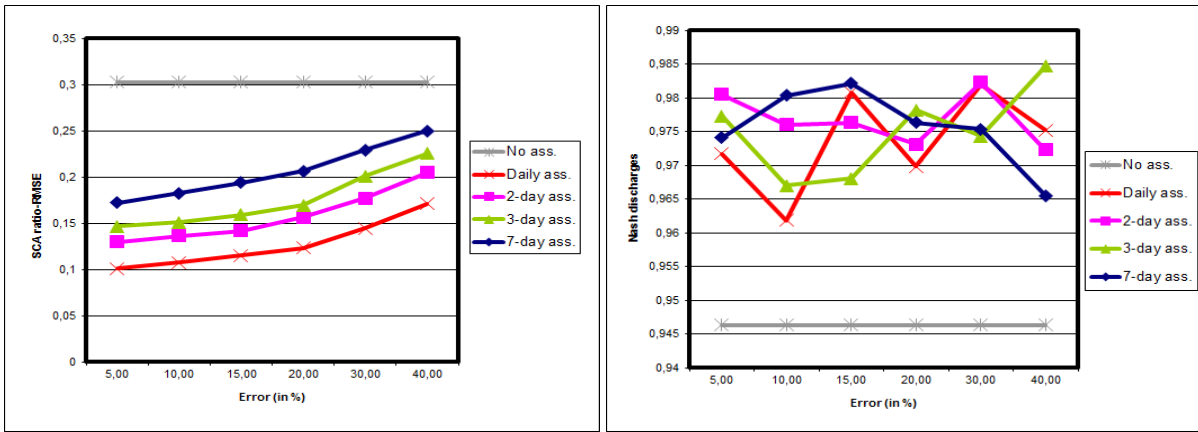
Figure 8. SCA ratio-RMSE ( left ) and Nash ( right ) for the synthetic SCA particle filter experiments on the whole Morava basin with 200